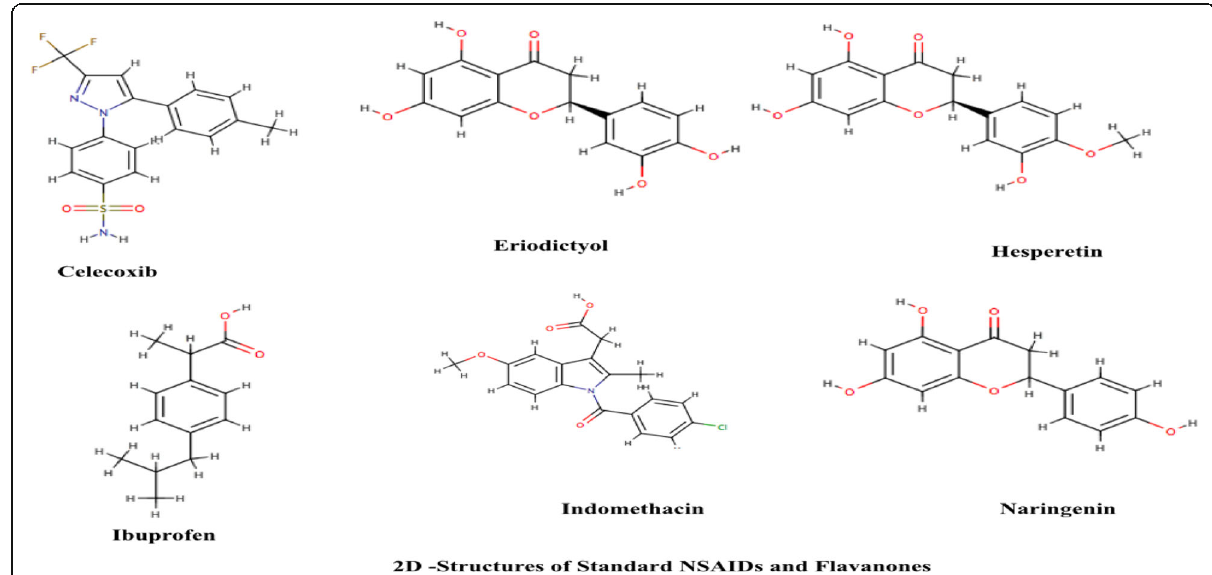
Fig. 2 The Ramachandran plot of the model human COX-1